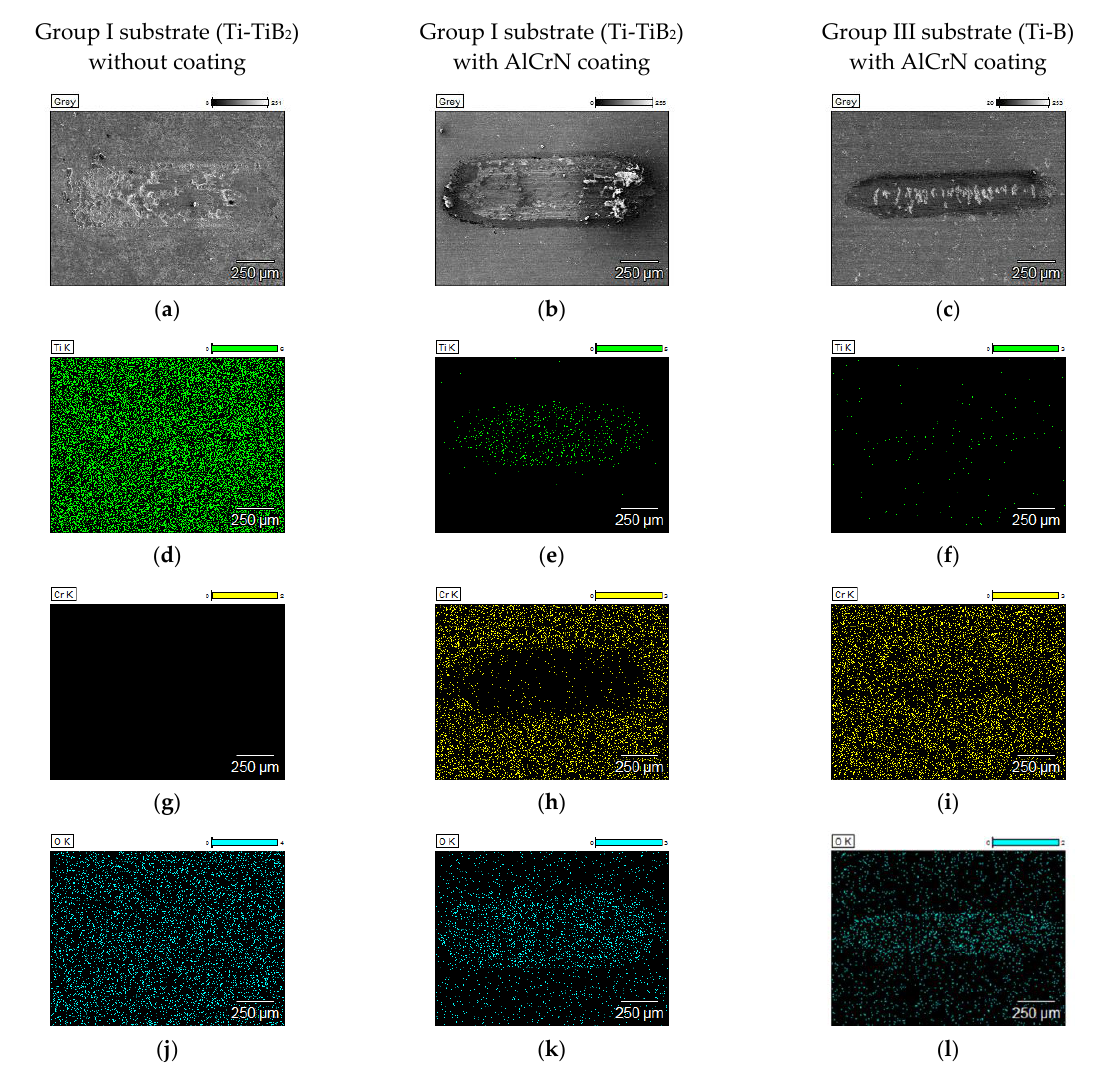
Figure 14. The EDS maps covering the wear tracks of the samples tested at 750 °C: ( a ) SEM image, Group I without coating, ( b ) SEM image, AlCrN/Group I, ( c ) SEM image, AlCrN/Group III, ( d ) Ti map, Group I without coating, ( e ) Ti map, AlCrN/Group I, ( f ) Ti map, AlCrN/Group III, ( g ) Cr map, Group I without coating, ( h ) Cr map, AlCrN/Group I, ( i ) Cr map, AlCrN/Group III, ( j ) O map, Group I without coating, ( k ) O map, AlCrN/Group I, ( l ) O map, AlCrN/Group